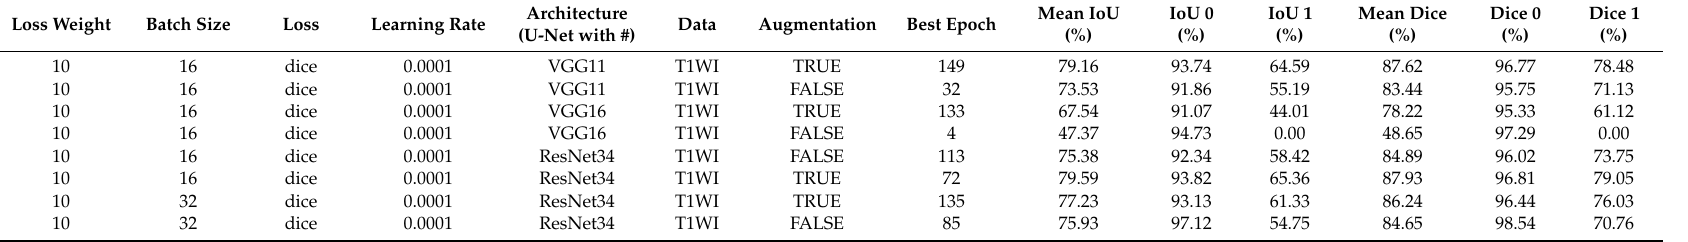
Table A5. Parameters and performance of all three architectures on “contrast-enhanced T1w” of the